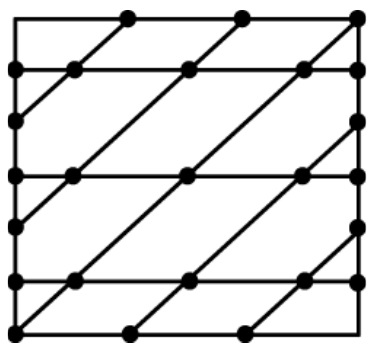
Figure 25. Schematic of a fracture network made of two sets of equally spaced and parallel fractures.